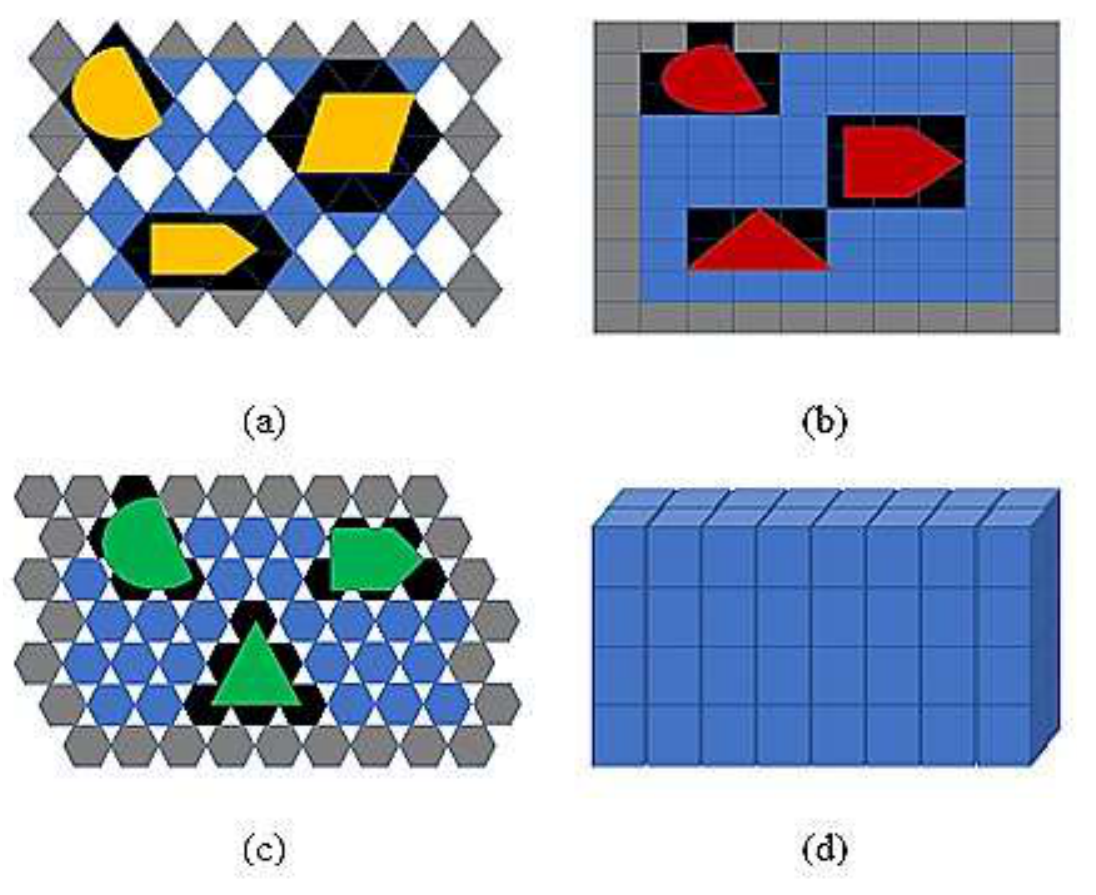
Figure 3. ( a ) Top left: 2D triangular grid with obstacles, ( b ) top right: 2D square (octile) grid with obstacles, ( c ) bottom left: 2D hexagonal grid with obstacles, ( d ) bottom right: 3D cubic grid without obstacles.